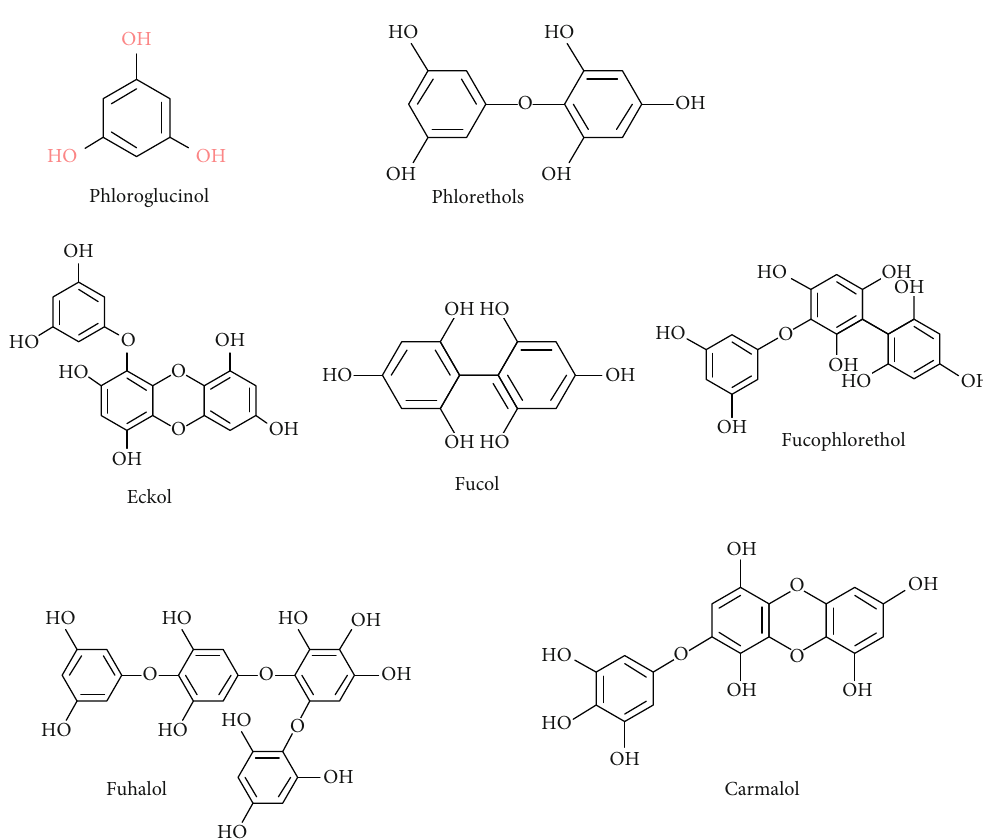
Figure 2: Chemical structure of phloroglucinol and groups of